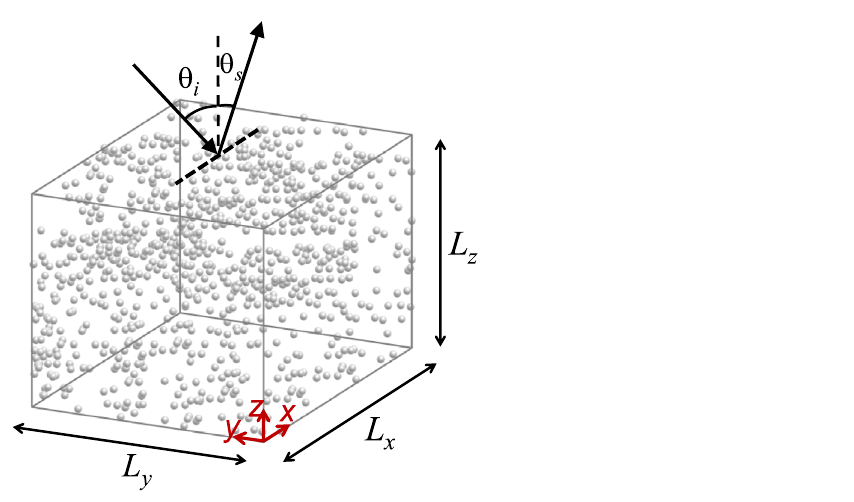
Figure 1. Simulation setup composed of N p particles randomly arranged inside a rectangular region with dimensions L x , L y , and L z . The structure is illuminated by a plane wave propagating in the xz-plane with the incident angle of θ i . The area between the dielectric particles is filled with air and the scattering is calculated in the upper half plane for − π (cid:31) 2 ≤ θ s ≤ π (cid:31) 2